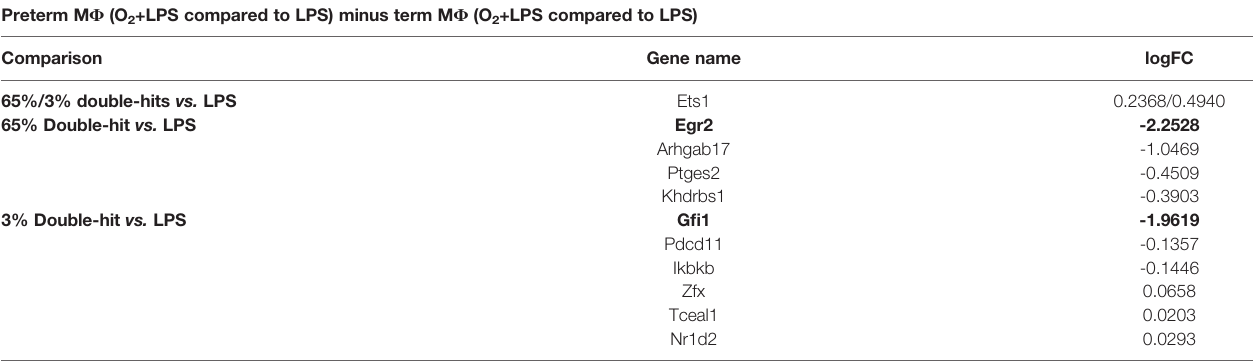
TABLE 2 | Key transcriptional regulators signi fi cantly regulated in preterm macrophages exposed to various oxygen concentrations and LPS compared to term M F